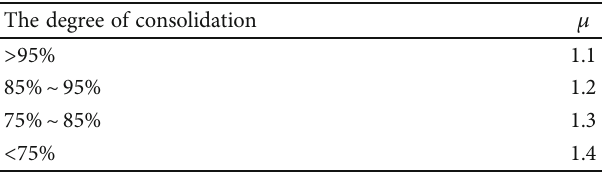
Table 4: Correction factor.